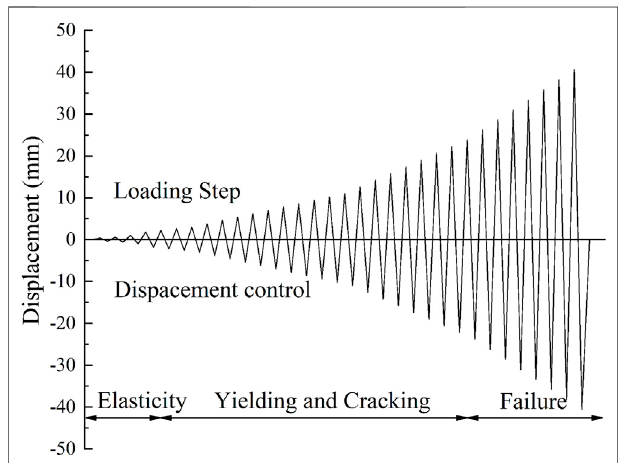
FIGURE 4 | Horizontal loading